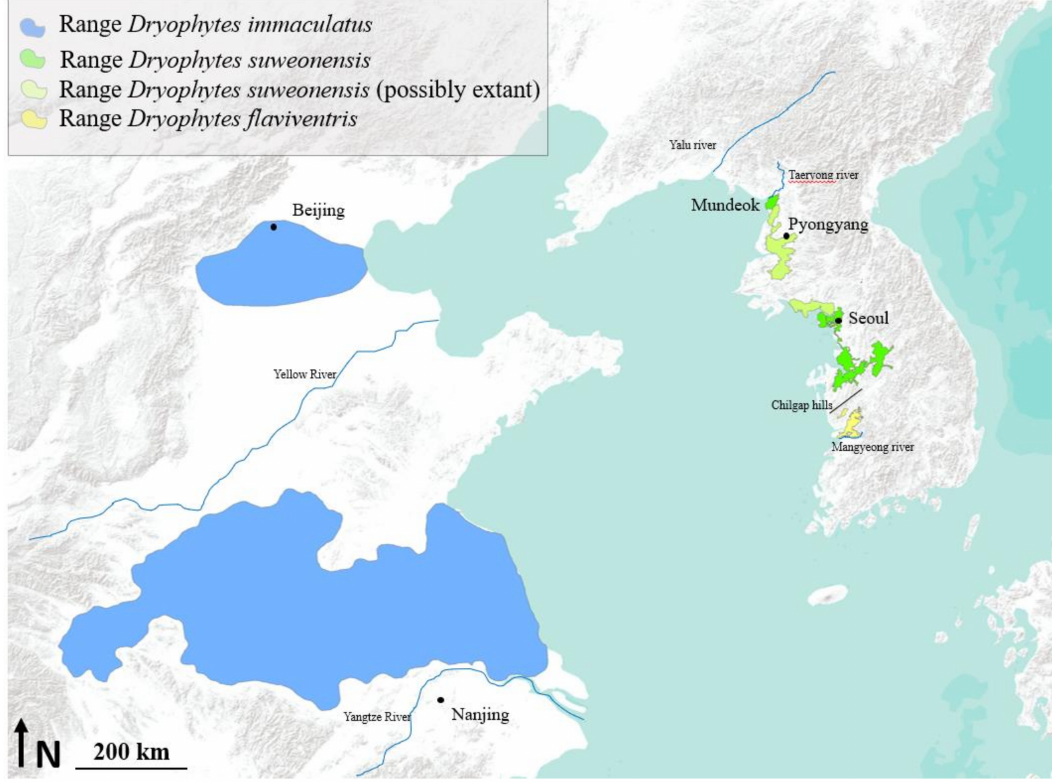
Figure 1. Range map for all three species from the “ Dryophytes immaculatus group”. Ranges for the three species extracted from Borz é e et al. [33]. Background map computed in ArcMap 10.6 (ESRI, Redlands,